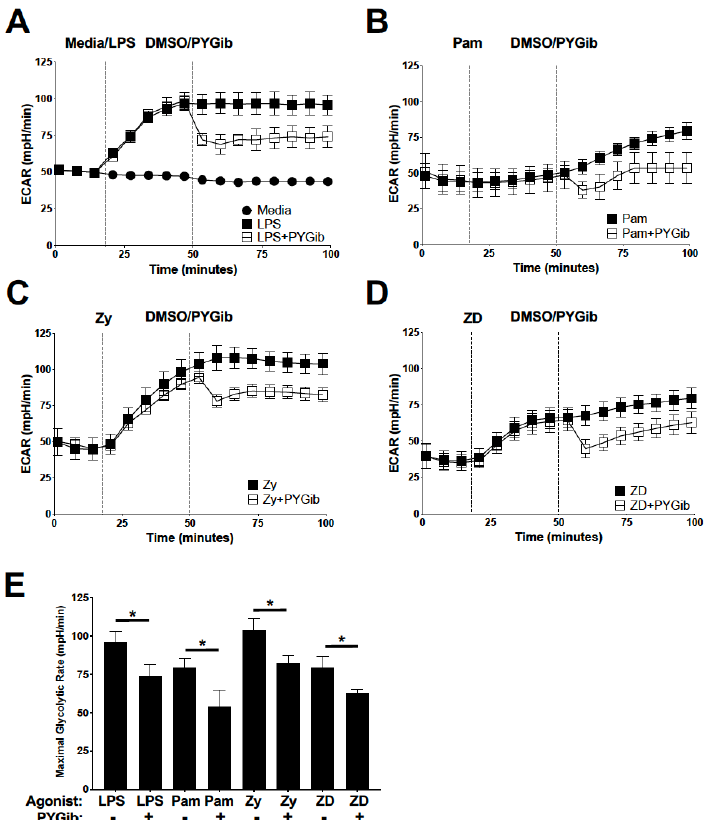
Figure 1. Glycogen metabolism contributes to glycolytic metabolic reprogramming in response to both TLR and CLR agonists: ( A – D ) extracellular flux analysis for real-time glycolysis rates were measured for DCs stimulated with the indicated agonists (LPS = lipopolysaccharide ( A ), Pam = Pam2CSK4 ( B ), Zy = Zymosan ( C ), and ZD = Zymosan depleted ( D )), followed by subsequent injection of PYG inhibitor (PYGib). ( E ) Statistical comparison of maximal glycolysis rates following PYGib/DMSO control addition for each agonist. For all graphs, statistical values are represented with an asterisk (*) as significant when p values are equal to or below 0.05, with mean +/ − SD shown, n = 4.